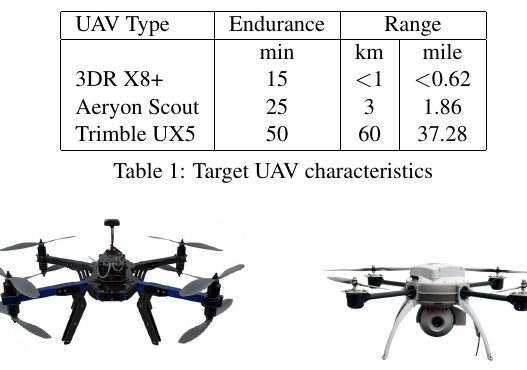
Figure 1: 3DR X8+ Figure 2: Aeryon Scout